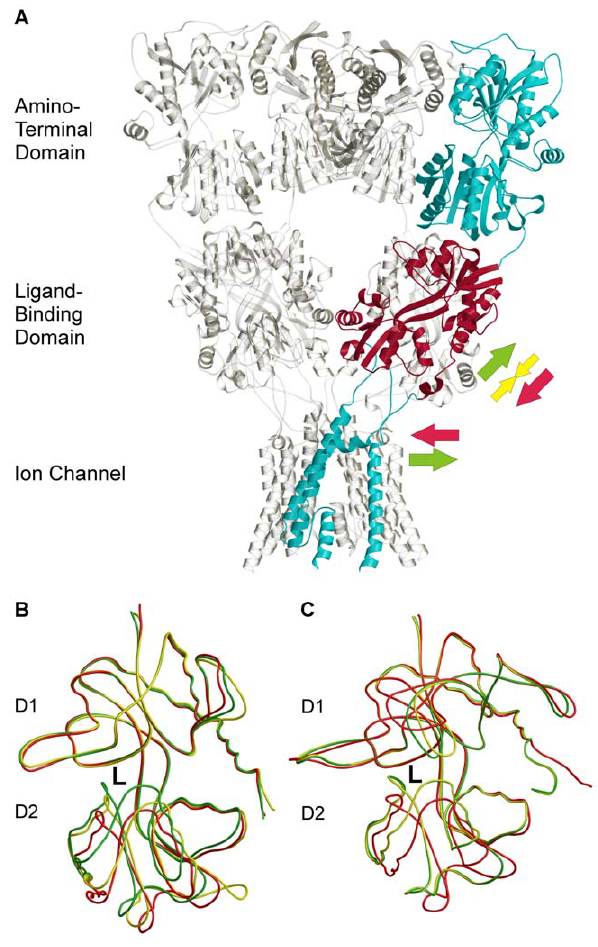
Figure 1. The crystal structure of iGluRs. (A) The crystal structure of GluA2 shows that it functions as a tetramer and (B) that the closure of the LBD determines the pharmacological behavior of GluA2. (C) On the contrary to GluA2, partial agonism of the NMDA receptors is ambiguous. In (A), one LBD (from PDB: 3KG2) is highlighted in red. The arrows depict the potential forces that occur during full agonist binding (green), partial agonist binding (yellow), and closure of the ion channel (red). In (B) and (C), superimposed structures with full agonist (green), partial agonist (yellow), and antagonist (red) are shown. Ligand binding site between domains D1 and D2 is depicted as letter L. Structures (PDB-codes) used are 3KG2 [7] in (A), 1FTJ, 1FTK, and 1FTL [13] in (B) and 1PB7, 1PB9, and 1Y1M [11], [12] in